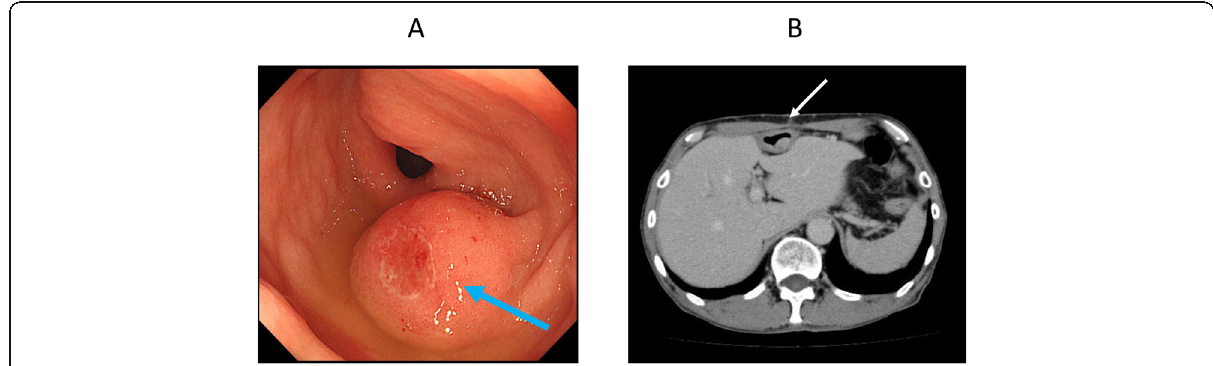
Fig. 1 a EGD before chemotherapy. Submucosal tumor in the pyloric part of the gastric tube (blue arrow). EGD, esophagogastroduodenoscopy. b CT before chemotherapy. A 7-mm tumor (white arrow) located in the gastric tube. CT, computed